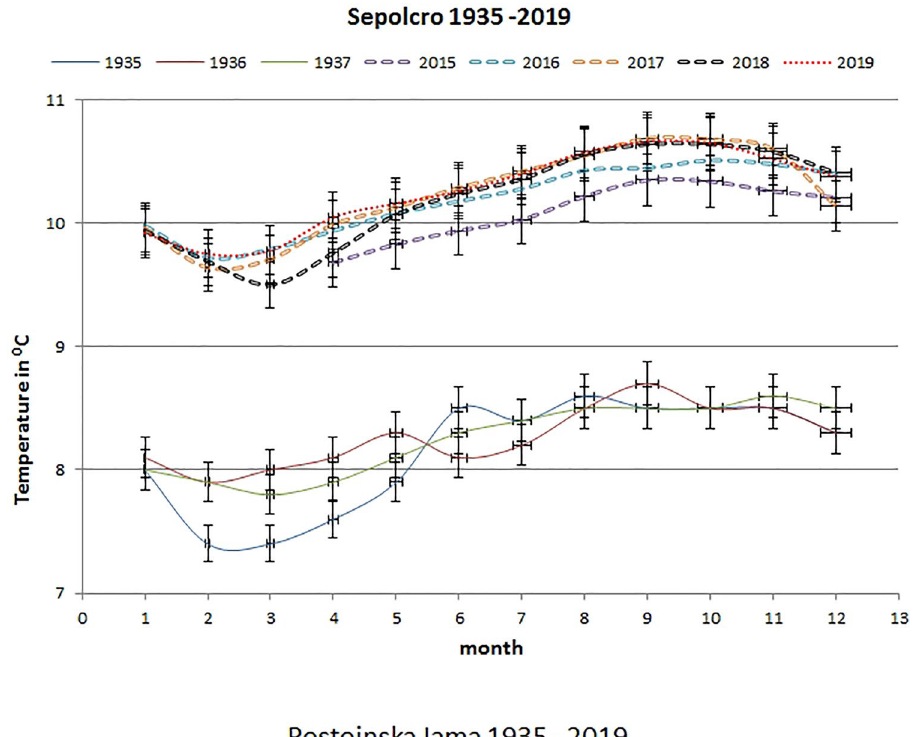
Fig. 4 Mean annual air tem- peratures (in °C) in Postojnska Jama and outside the cave with annual visitor numbers for the period 1935–2019. Histori- cal data are from Crestani